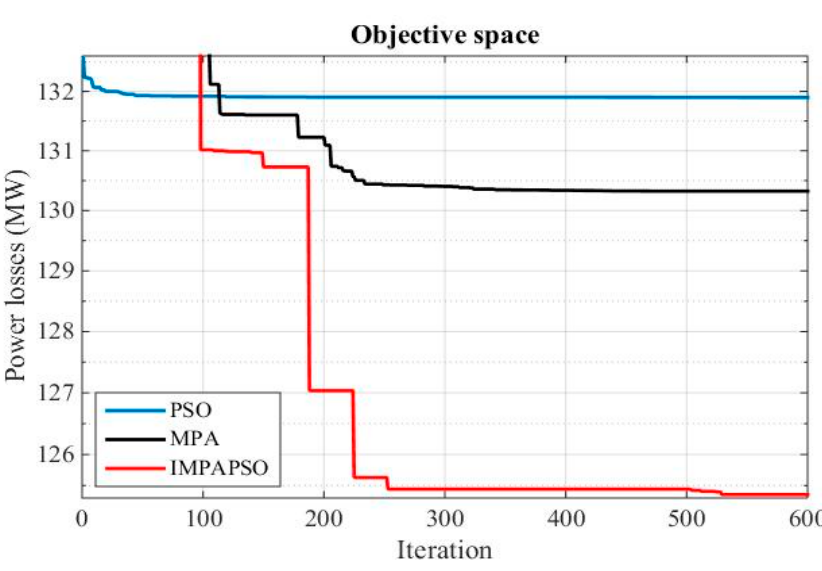
Figure 12. Convergence of PSO and IMPAPSO in the second case of the IEEE 118-bus system. The results of power losses in the 118 bus system obtained by different optimization methods are presented in the bar chart, as shown Figure 13. A comparison of these results showed that the value of power losses obtained by the IMPAPSO algorithm was the best among the results obtained by other algorithms, especially the ABC and the FA.